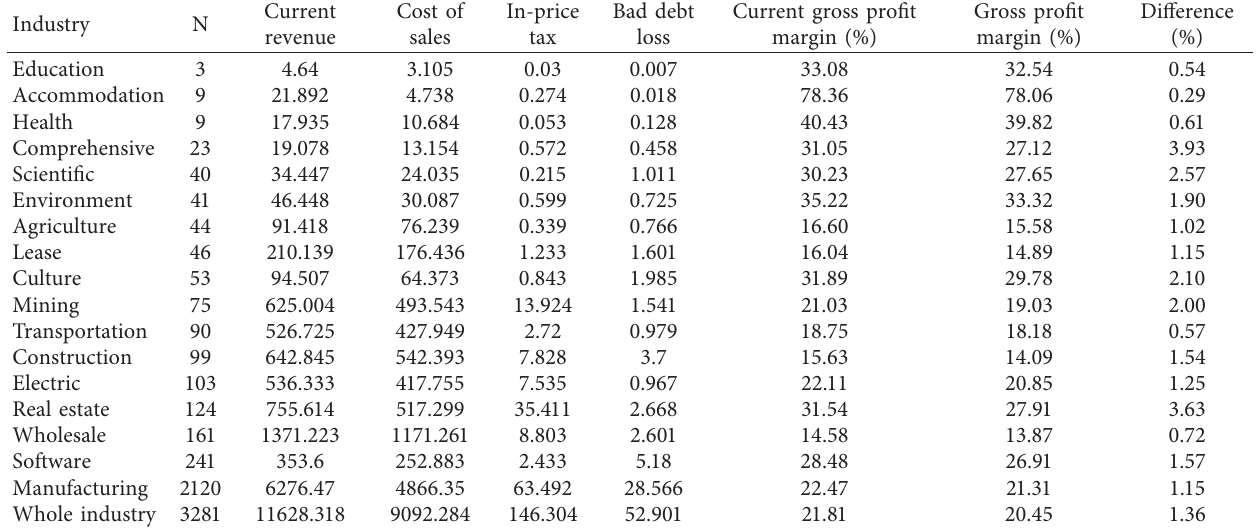
Table 5: Overestimation of gross profit margin of listed companies by industry in